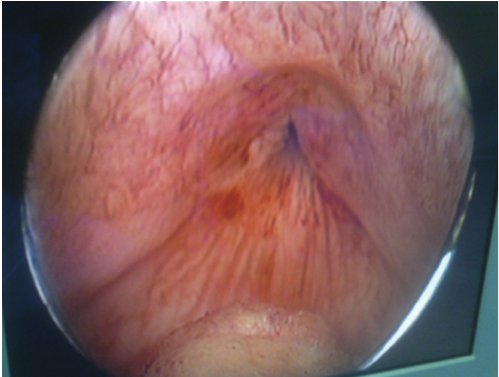
Figure 3: Cystoscopy showing bladder neck